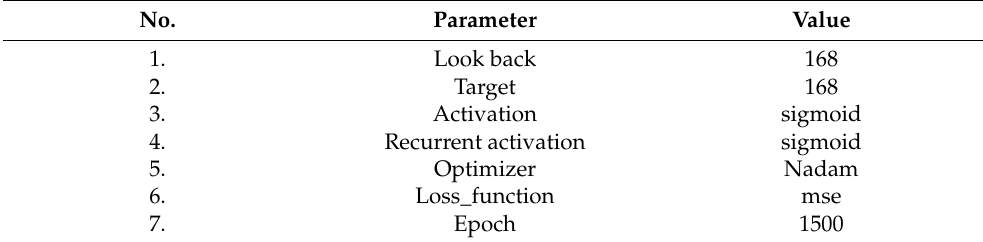
Table 4. Parameter setting for RNN with many-to-many